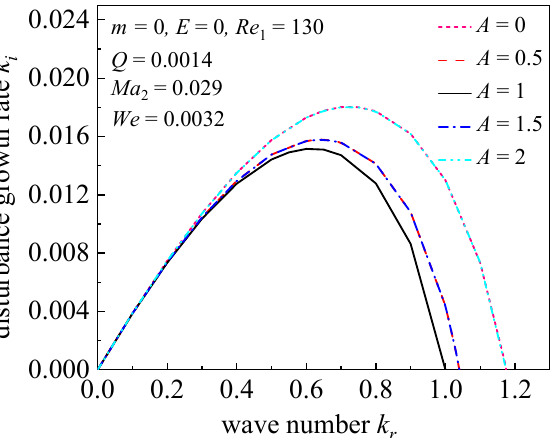
Figure 3. Variation of disturbance growth rates with axial wave numbers under the weak airflow ejection.